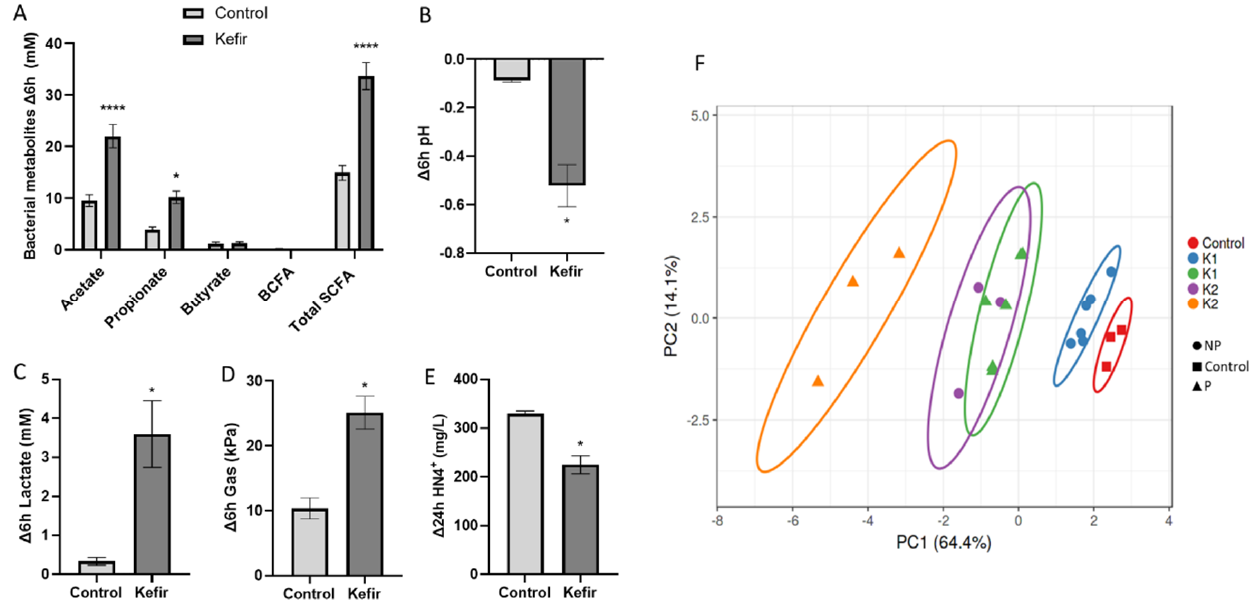
Figure 2. Effect of kefir supplementation on bacterial-derived metabolites. ( A – E ) Bars represent the delta change at 6 h ( ∆ 6 h) for SCFA and BCFA ( A , B ), pH ( C ), lactate ( D ) and gas ( E ), and at 24 h ( ∆ 24 h) for ammonia. Values are expressed as mean ± SEM of control ( n = 3) or kefir-treated ( n = 9) reactors. Significant differences are marked with asterisks (* p < 0.05, **** p < 0.0001). ( F ) Principal Component Analysis plot of microbial metabolic markers, including absolute values of pH, gas, lactate, SCFA, BCFA and ammonia at 6, 24 and 48 h. Ellipses are drawn at 95% confidence interval.